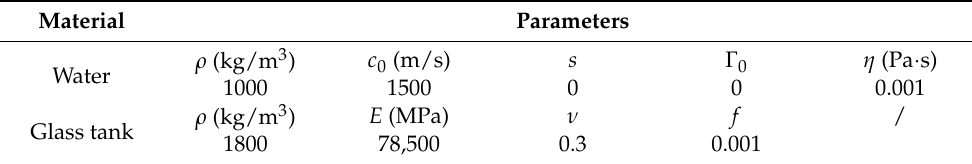
Figure 4. Geometry of the water collapse simulation: ( a ) plane dimension of the model; ( b ) boundary conditions of the three-dimension model. Table 1. Numerical parameters of the water collapse